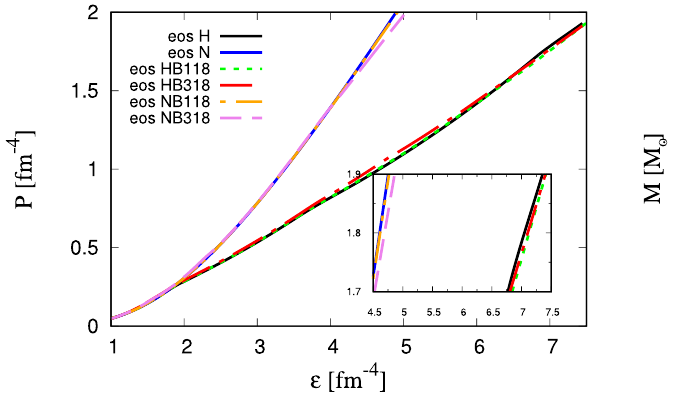
Fig. 2 The mass–radius relation is plotted for the six EOS shown in Fig.